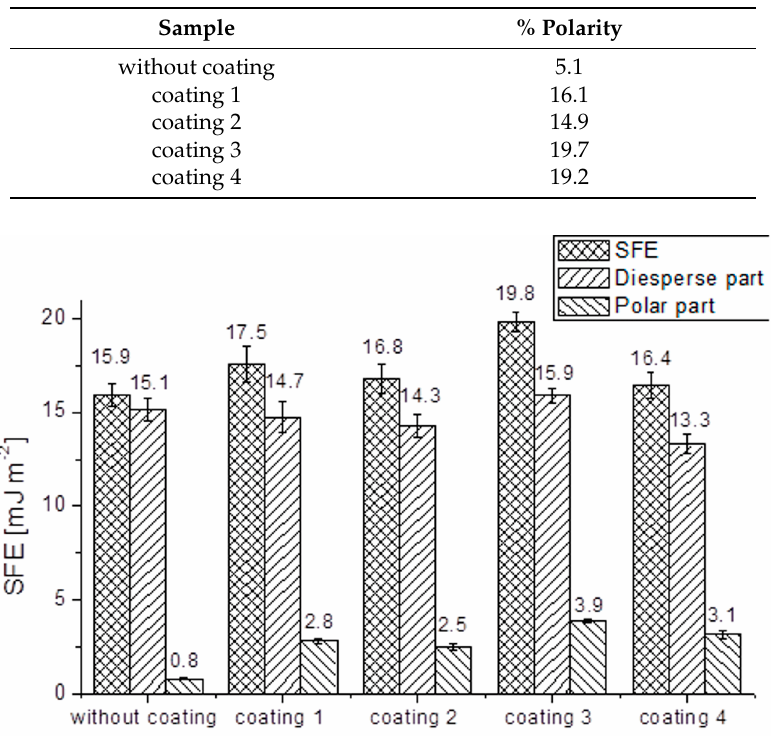
Table 1. Polar character of fibers without and with individual coatings.